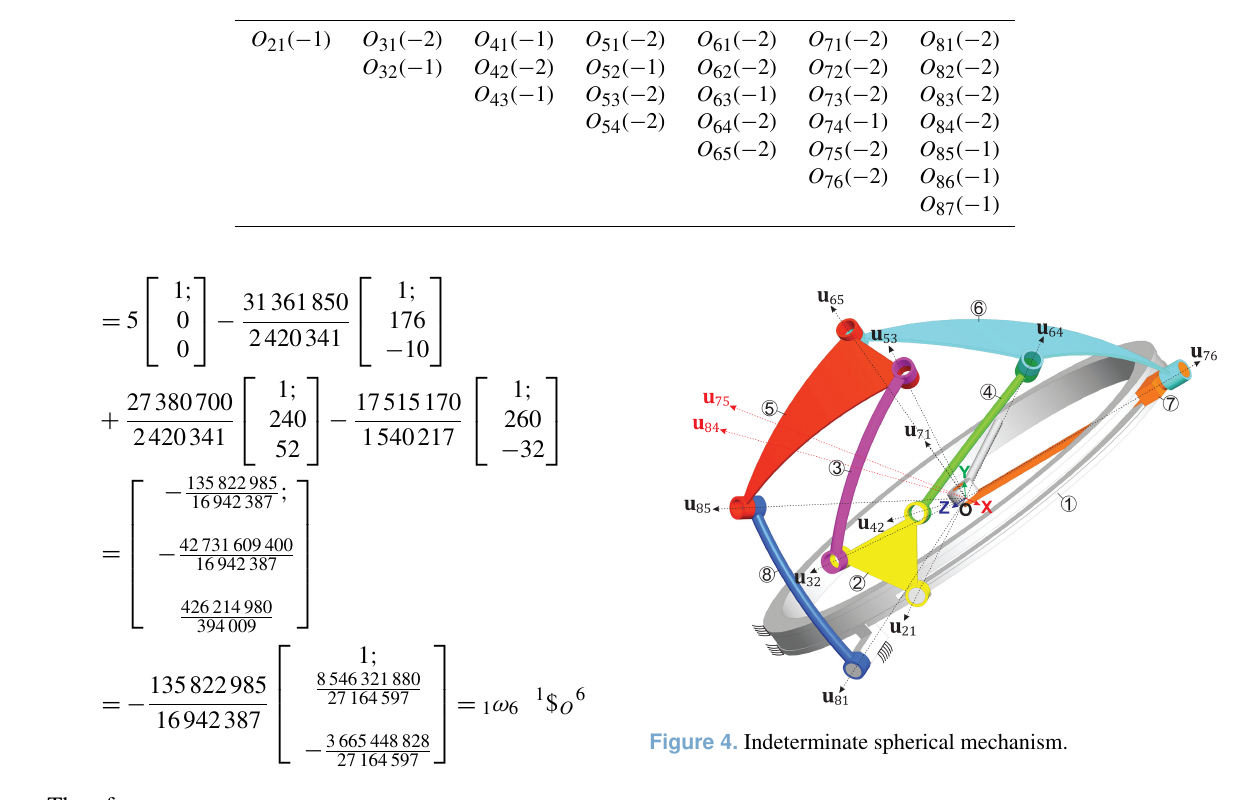
Table 1. Instantaneous centers of velocity associated with the single flyer linkage.